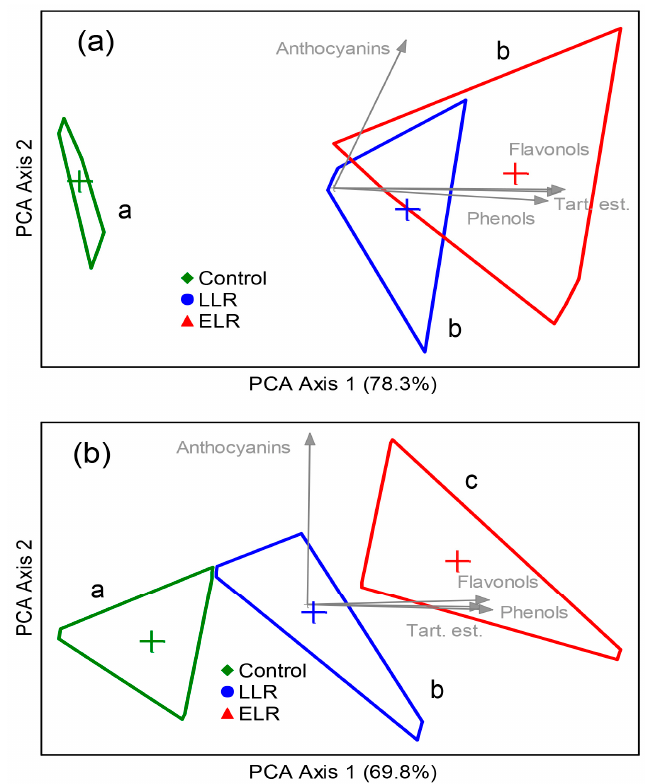
Figure 5. Major gradients (PCA ordination) in the concentrations of four major types of chemical compounds determined by HPLC in the berry skin ( a ) and the wine (after 6 months of aging) ( b ) of Cabernet Sauvignon across the three treatments: Control (no leaf removal); LLR (late leaf removal) and ELR (early leaf removal). The values in parenthesis denote the proportion of variance represented by a statistically significant PCA axis. The angles and lengths of the radiating lines indicate the direction and strength of relationships of the variables with the ordination scores. Data matrix: 27 samples collected over three consecutive years (2011–2013), 4 measured variables, correlation cross-product matrix, Euclidean distance, no rotation. Group centroids (crosses) show the average position of a sample within each treatment. Convex hulls (polygons) encompass all the samples in each treatment. Different letters denote that biochemical fingerprints of the leaf removal treatments, as characterized by the 4 measured variables, are statistically different according to the MRPP test, p < 0.05. All the variables were correlated with the ordination scores by